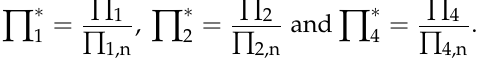
Figure 1. Presenting the relationship between the criterions Π 1 * and Π 4 *.